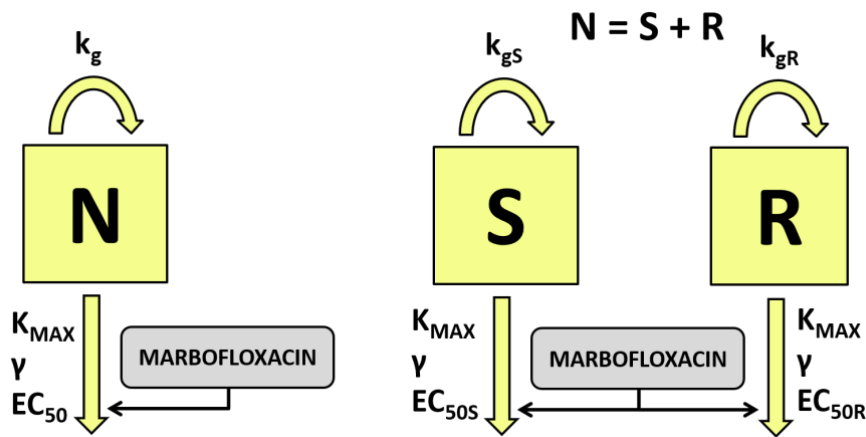
Figure 1. Semi-mechanistic pharmacodynamic models for time kill curves modeling. On the left, a simple one population bacterial model was used to fit the data. Bacteria growing at growth rate constant are exposed to marbofloxacin concentrations with a maximum killing rate constant K MAX and free drug concentration to achieve 50% of killing EC 50 . On the right, two compartmental bacterial model was used. Two populations S and R of bacteria growing at growth rate constants of k gS and k gR are exposed to marbofloxacin with a killing rate constant K MAX and different drug concentration to achieve 50% of killing ( EC 50 S and EC 50 R ).